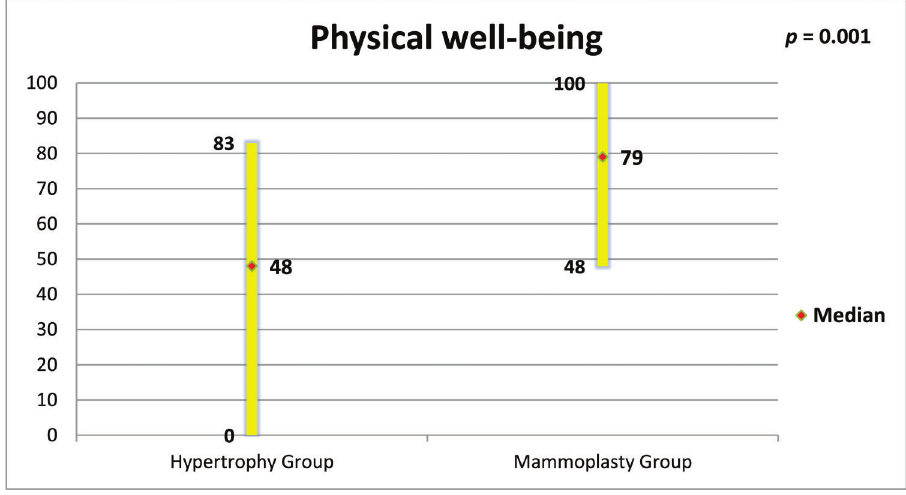
Figure 8 - Scores of BREAST-Q s subscale ‘‘ Physical well-being ’’ in both groups and comparison by the Mann-Whitney test.